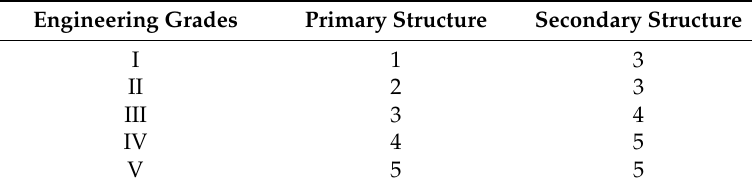
Table 2. Permanent hydraulic structure classification.